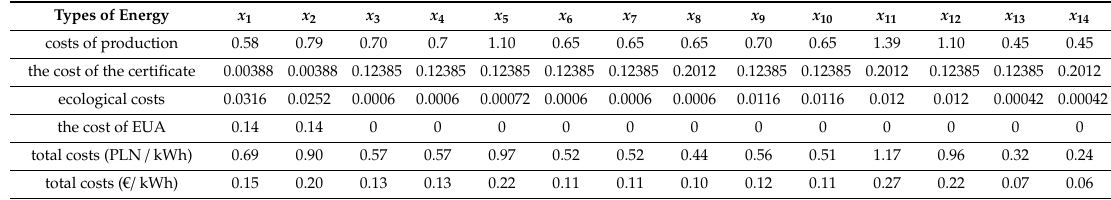
Table 6. The amount of the cost for each type of energy expressed in Polish currency.